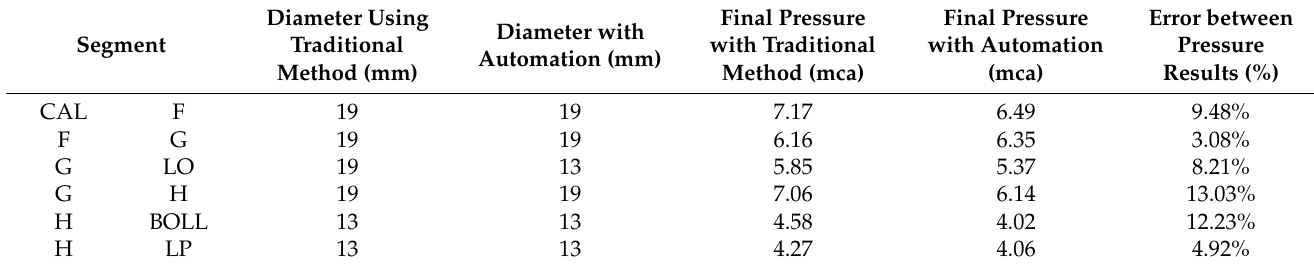
Table 23. Comparison of diameters and final hot water pressure for type 1 retail